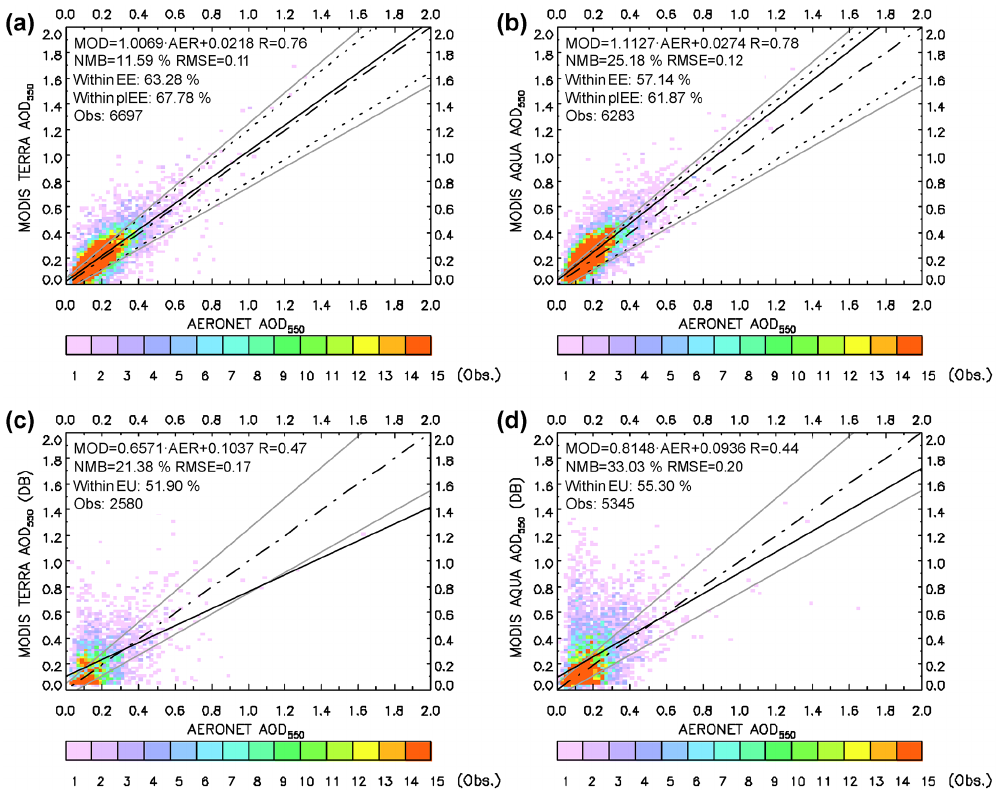
Figure 3. Comparison of spatially (using a 25 × 25km 2 window around each station) and temporally ( ± 30min from the MODIS overpass time) collocated MODIS Collection 051 level-2 and AERONET sun photometric (quadratically interpolated) AOD 550 observations for the Eastern Mediterranean stations: (a) for MODIS Terra DT data, (b) for MODIS Aqua DT data, (c) for MODIS Terra DB data and (d) for MODIS Aqua DB data. The color scale corresponds to the number of MODIS–AERONET collocation points that fall within 0.02 × 0.02 grid boxes. The solid line is the regression line of the MODIS–AERONET observations, the dashed-dotted line is the 1:1 line, the dotted lines represent the expected error (EE) envelope and the gray lines the pre-launch expected error (plEE) envelope (expected uncertainty – EU envelope for DB data). The slope and the intercept of the regression line, the correlation coefficient R , the normalized mean bias (NMB), the root mean square error (RMSE), the percentage of the collocation points that fall within the EE and plEE and the number of all the collocation points are given on the